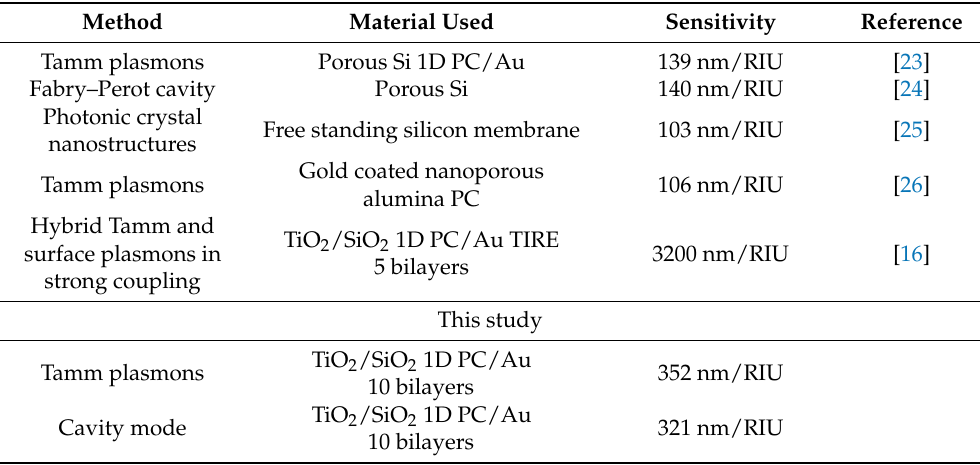
Table 2. Comparison of various nanophotonic structures for refractive index